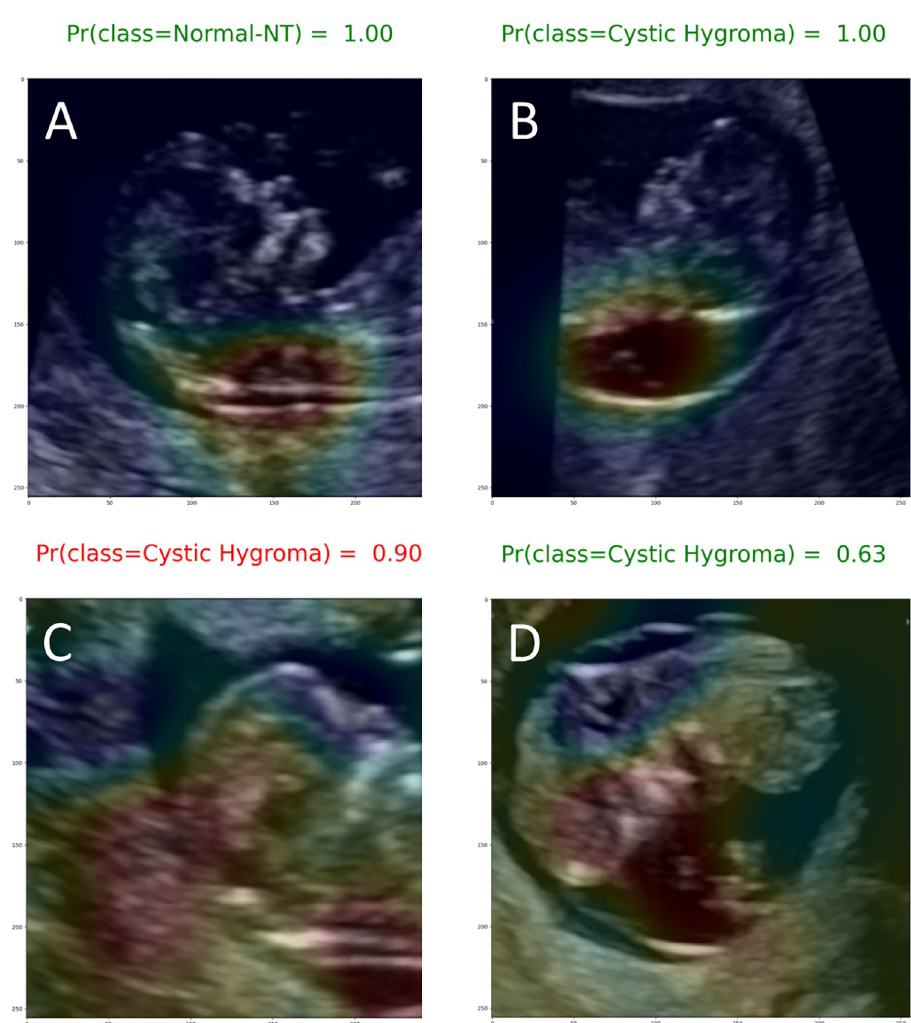
Fig 7. Exemplary Grad-CAM heat maps. (A) Normal NT case with good localization in which the model predicted the correct class with a high (1.00) output probability (true negative). (B) Cystic hygroma case with good localization in which the model predicted the correct class with a high (1.00) output probability (true positive). (C) Normal NT case showing poor localization in which the model predicted this class incorrectly with a 0.90 output probability (false positive). (D) Cystic hygroma case showing poor localization in which the model predicted the correct class, but with an output probability that suggests uncertainty (0.63) (true